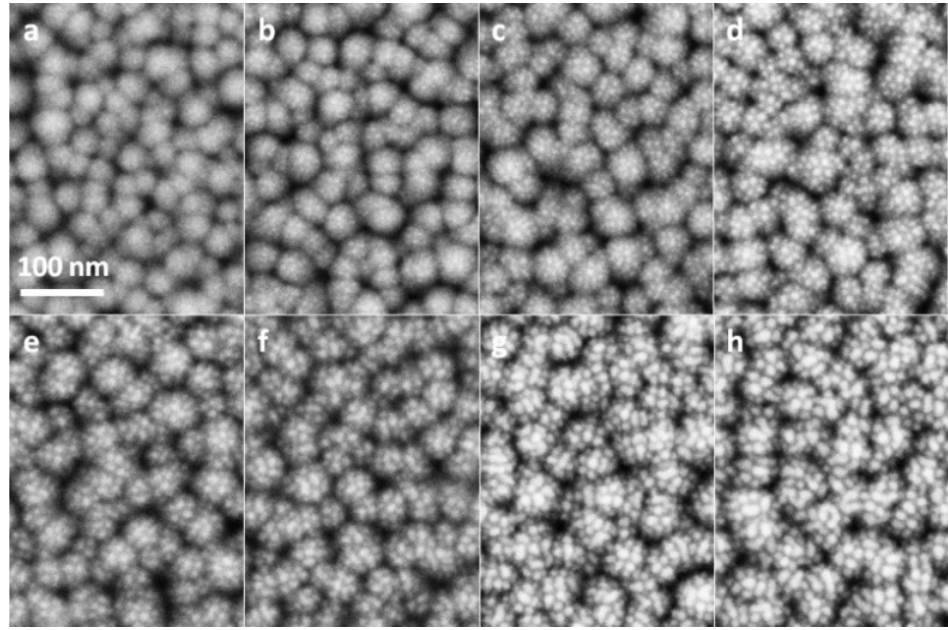
Figure 3. SEM images of Au@ZnO-film substrates with sputtering time of 20 s ( a ), 40 s ( b ), 60 s ( c ), 80 s ( d ), 100 s ( e ), 120 s ( f ), 140 s ( g ), and 160 s ( h ).